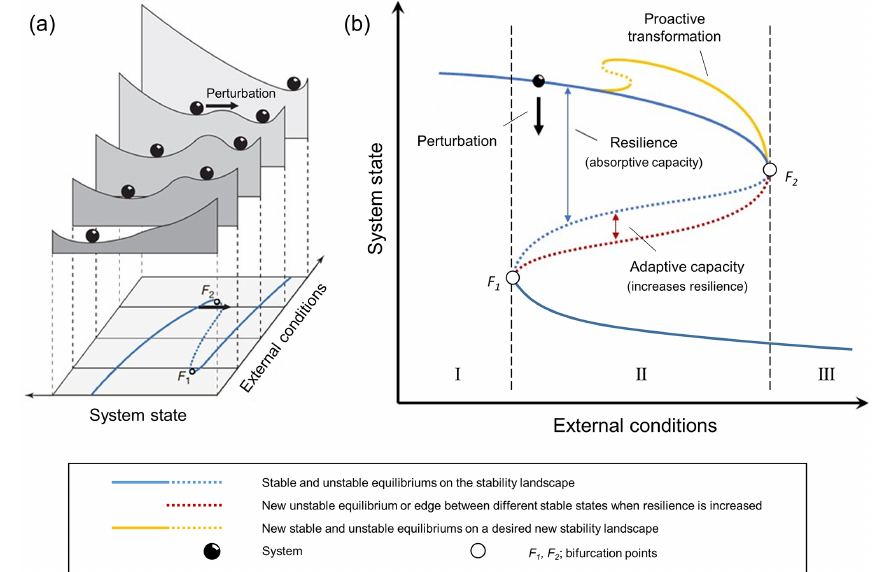
Figure 1. Bifurcation diagrams for socio-hydrological resilience: (a) stability landscape changes along with external conditions, adapted from Scheffer et al. (2001); (b) Bifurcation diagram illustrating absorptive, adaptive , and transformative capacities. The two dashed lines across F 1 and F 2 divide the bifurcation process into three phases. Phase I and III have only one stable equilibrium, while Phase II has two stable equilibriums. Perturbations in Phase II may drive the system from one stable state to another. Absorptive capacity refers to the original meaning of resilience; adaptive capacity refers to the capability to increase resilience in response to external change (red line); transformative capacity refers to the capacity to respond more radically, such as through proactively navigating the system to a desired new stability landscape (yellow line). Panel (a) is adapted with permission from Macmillan Publishers Ltd: Nature Vol. 413 Issue 6856, Scheffer et al., copyright